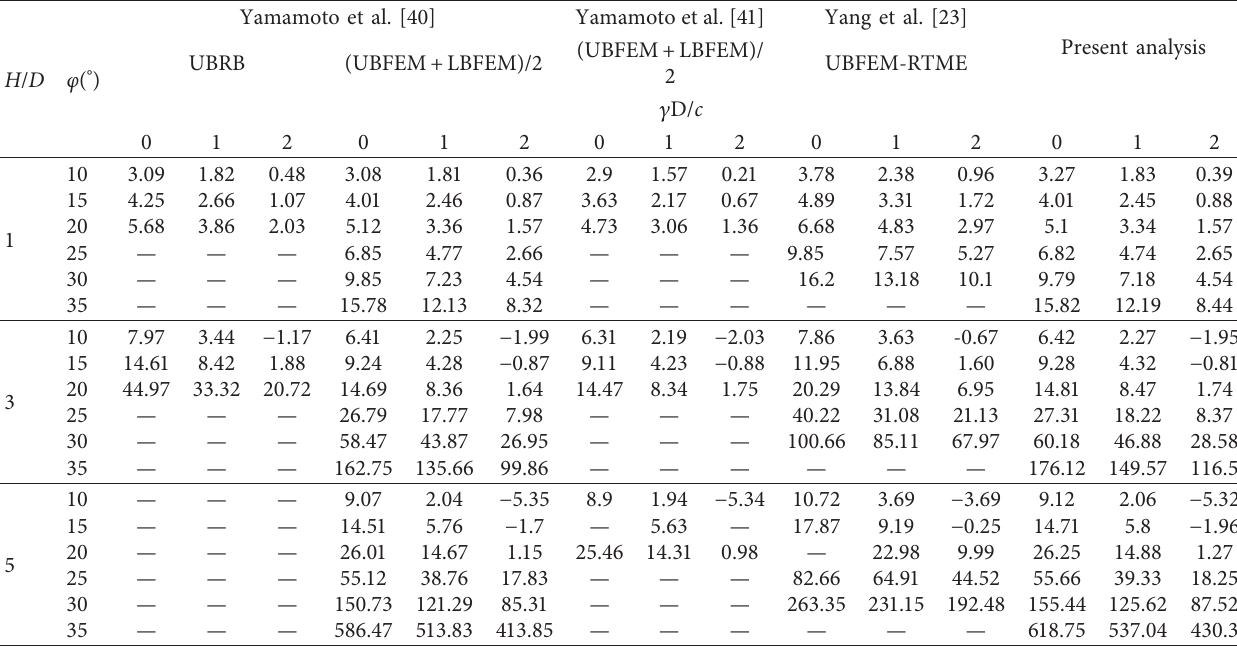
Table 1: Comparisons between the computed results and those reported in the literature.